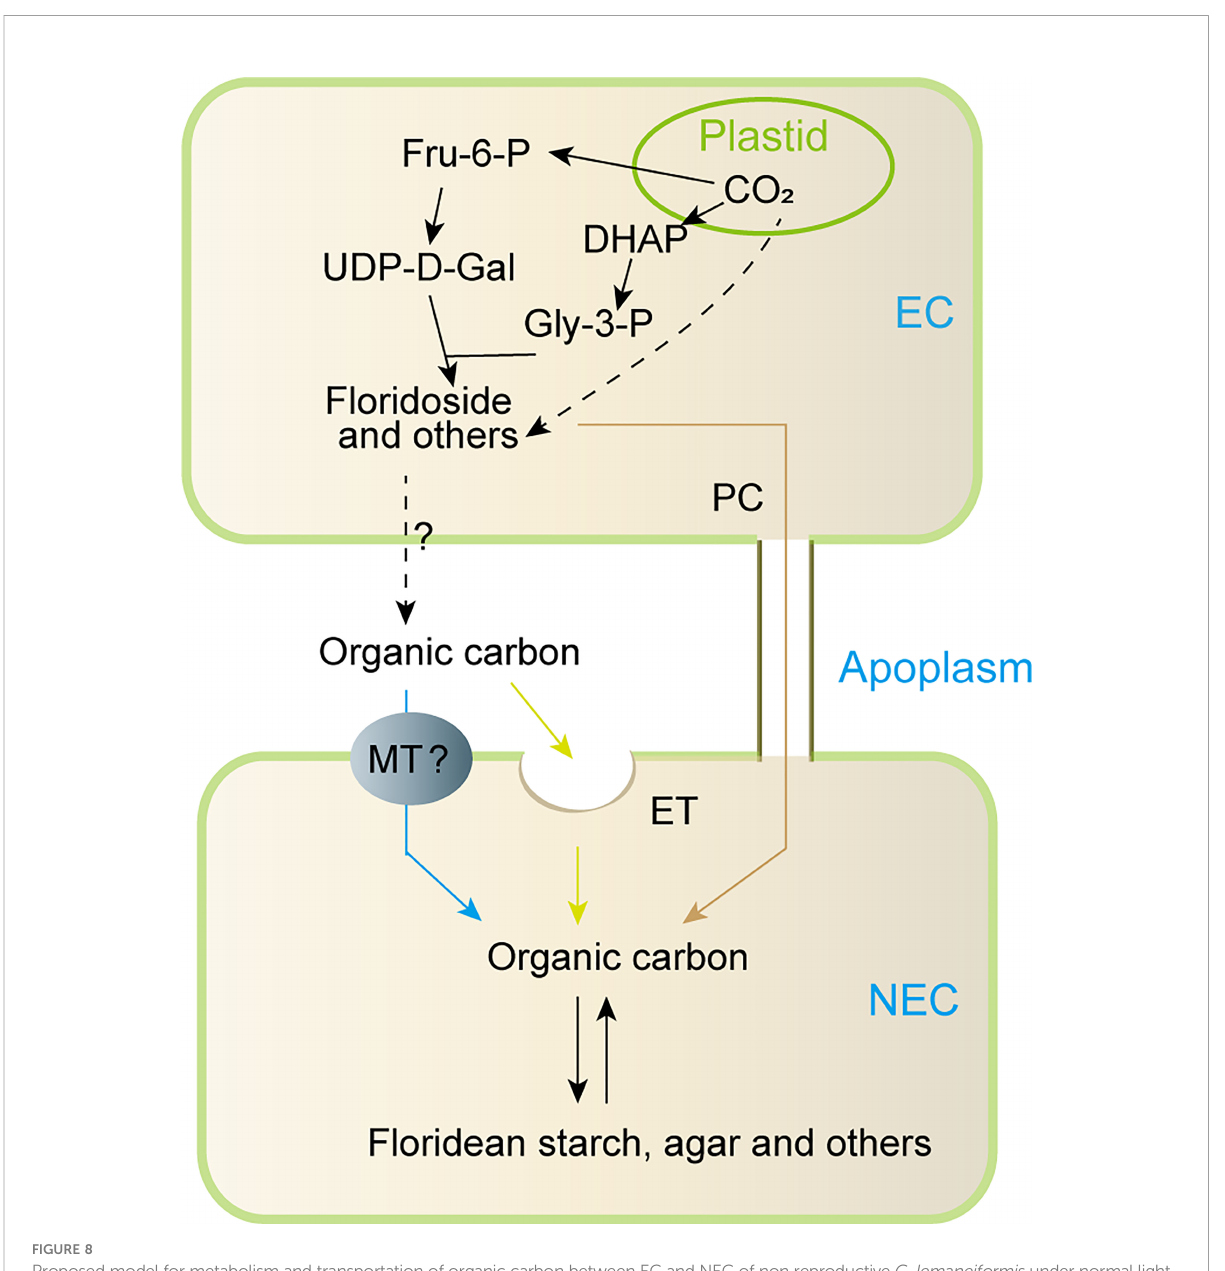
FIGURE 8 Proposed model for metabolism and transportation of organic carbon between EC and NEC of non reproductive G. lemaneiformis under normal light condition. Fru-6-P: fructose-6-phosphate, DHAP: dihydroxyacetone phosphate, UDP-D-Gal: UDP-D-galactose, Gly-3-P: glycerol-3-phosphate, EC: epidermal cells, NEC, non-epidermal cells; MT, membrane transporter; ET, endocytosis; PC, pit connection; “ ? ” , uncertainty